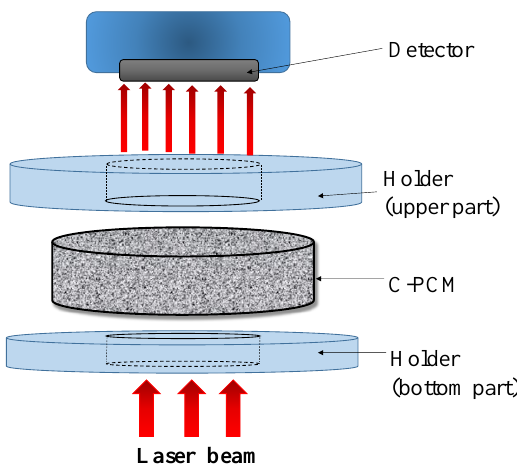
Figure 6. Scheme of the laser flash (LF) method applied to a C-PCM sample (adapted from [32] with permission of Elsevier).